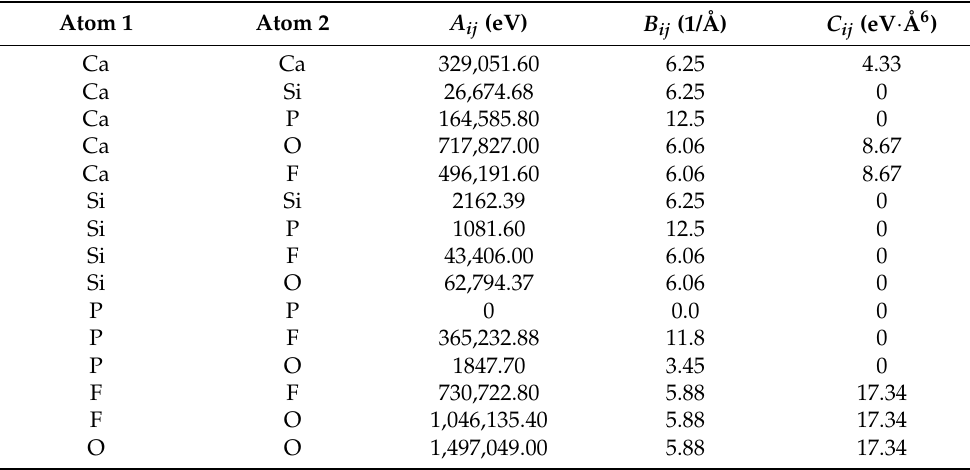
Table 1. Born–Mayer–Higgins potential parameters for atomic pairs in CaO-SiO 2 -CaF 2 -P 2 O 5